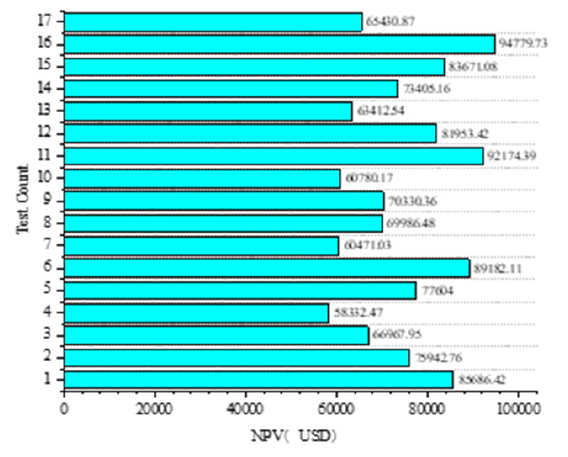
Figure 8. Net present value table .